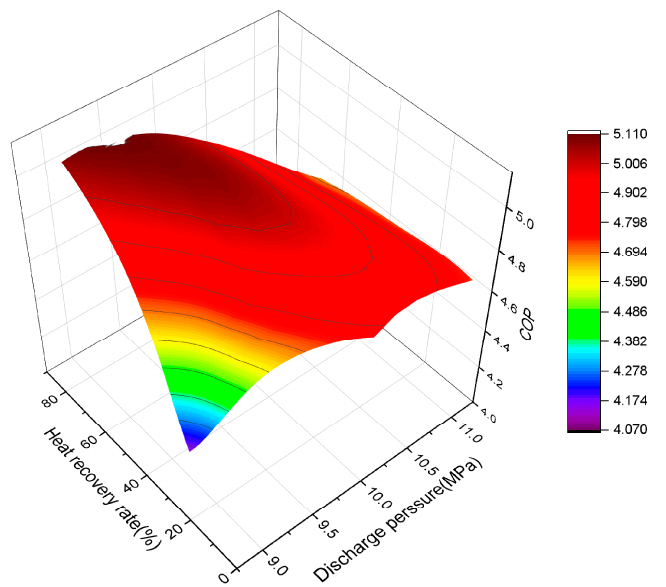
Figure 5. The collaborative optimization of the discharge pressure and heat recovery rate under 25 ° C in ambient temperature.